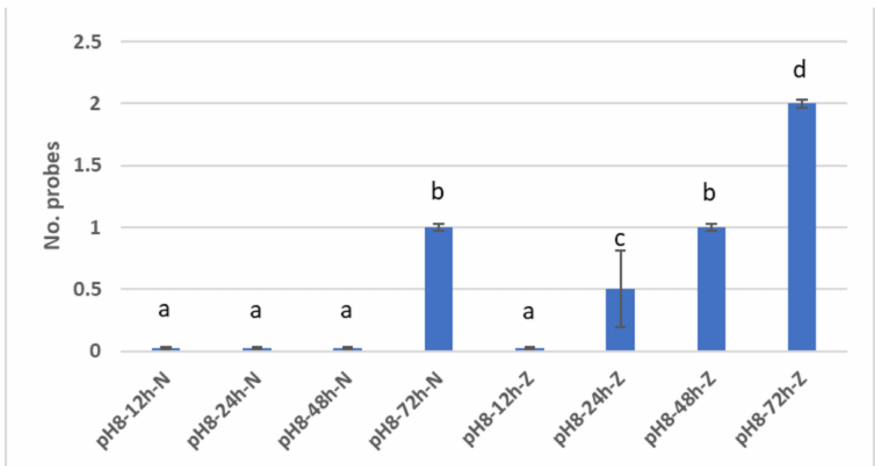
Figure 10. Remineralisation cycle: N and Z enamel samples. Different letters indicate statistically significant differences p ≤ 0.05 (Duncan’s